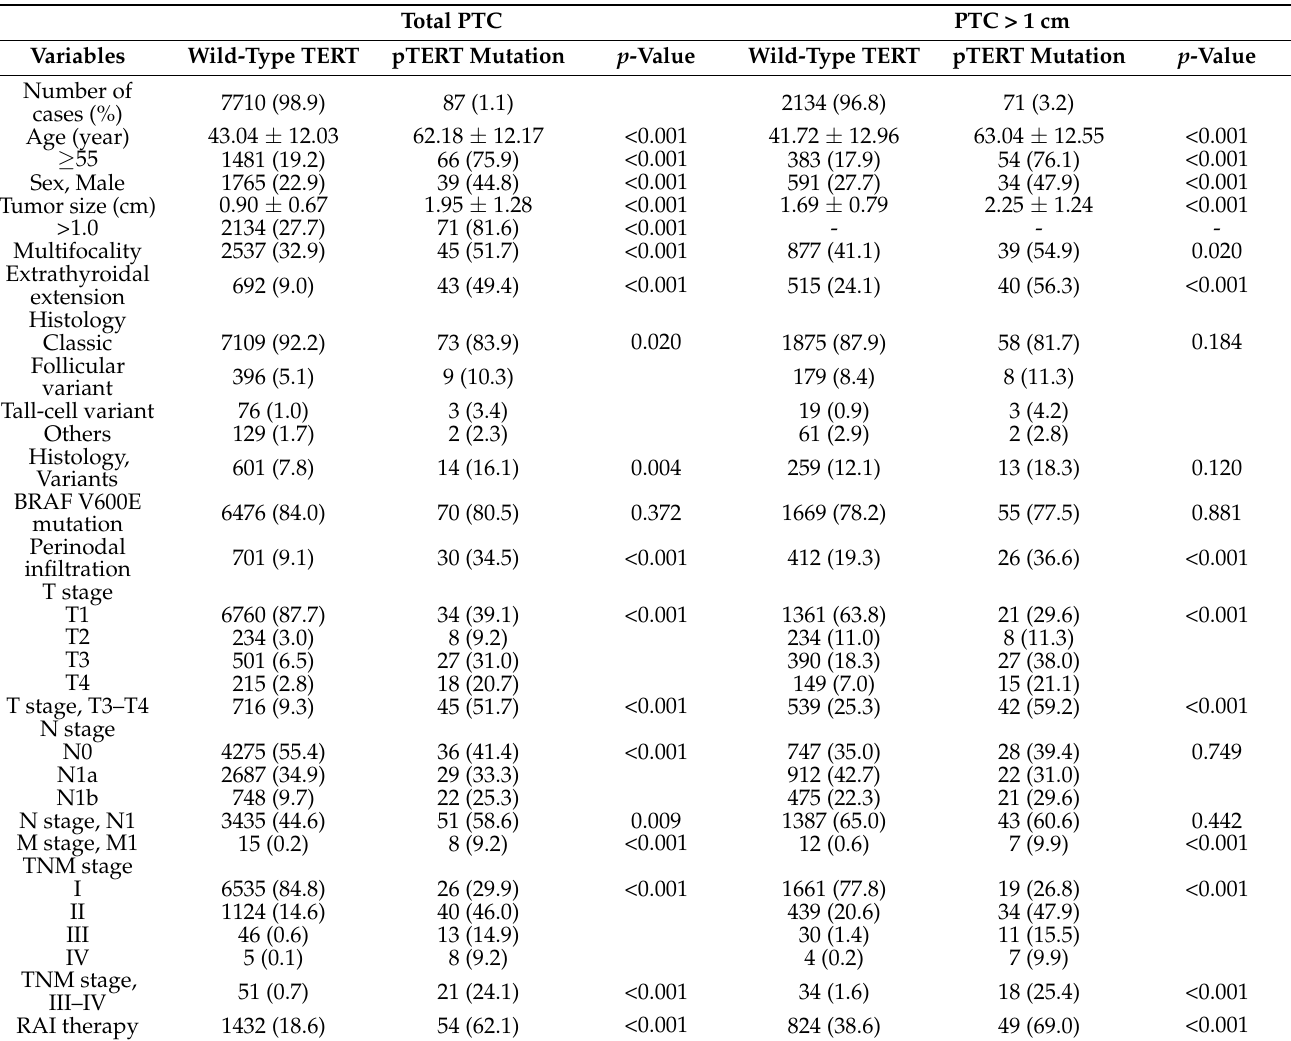
Table 2. TERT promoter mutations and clinicopathologic features in patients with